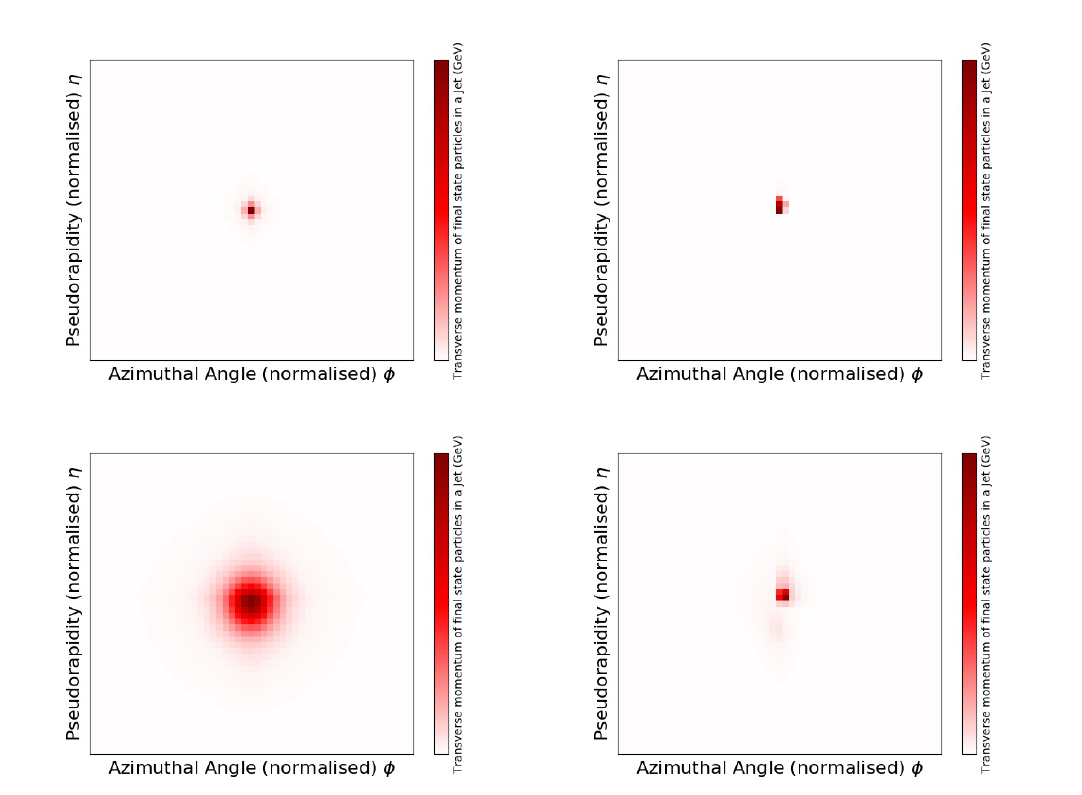
Figure 1: Average top quark signal (background) sample image on the top (bottom) after the preprocessing in [ 13 ] on the left and after preprocessing in [ 14 ] on the right.